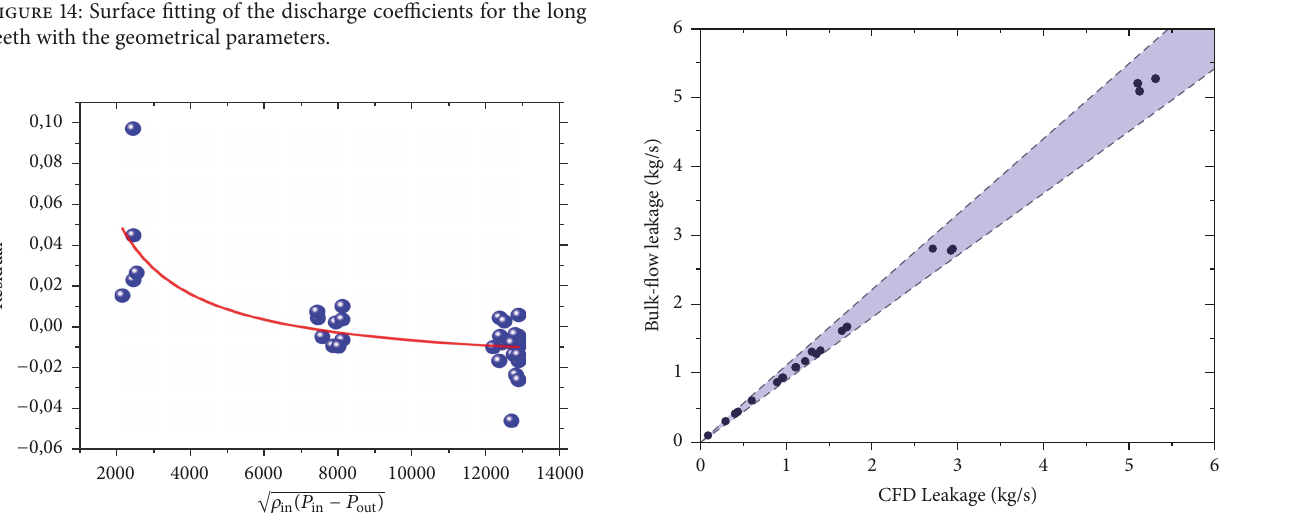
Figure 15: Curve fitting of the residual for the short teeth with the operating parameter.